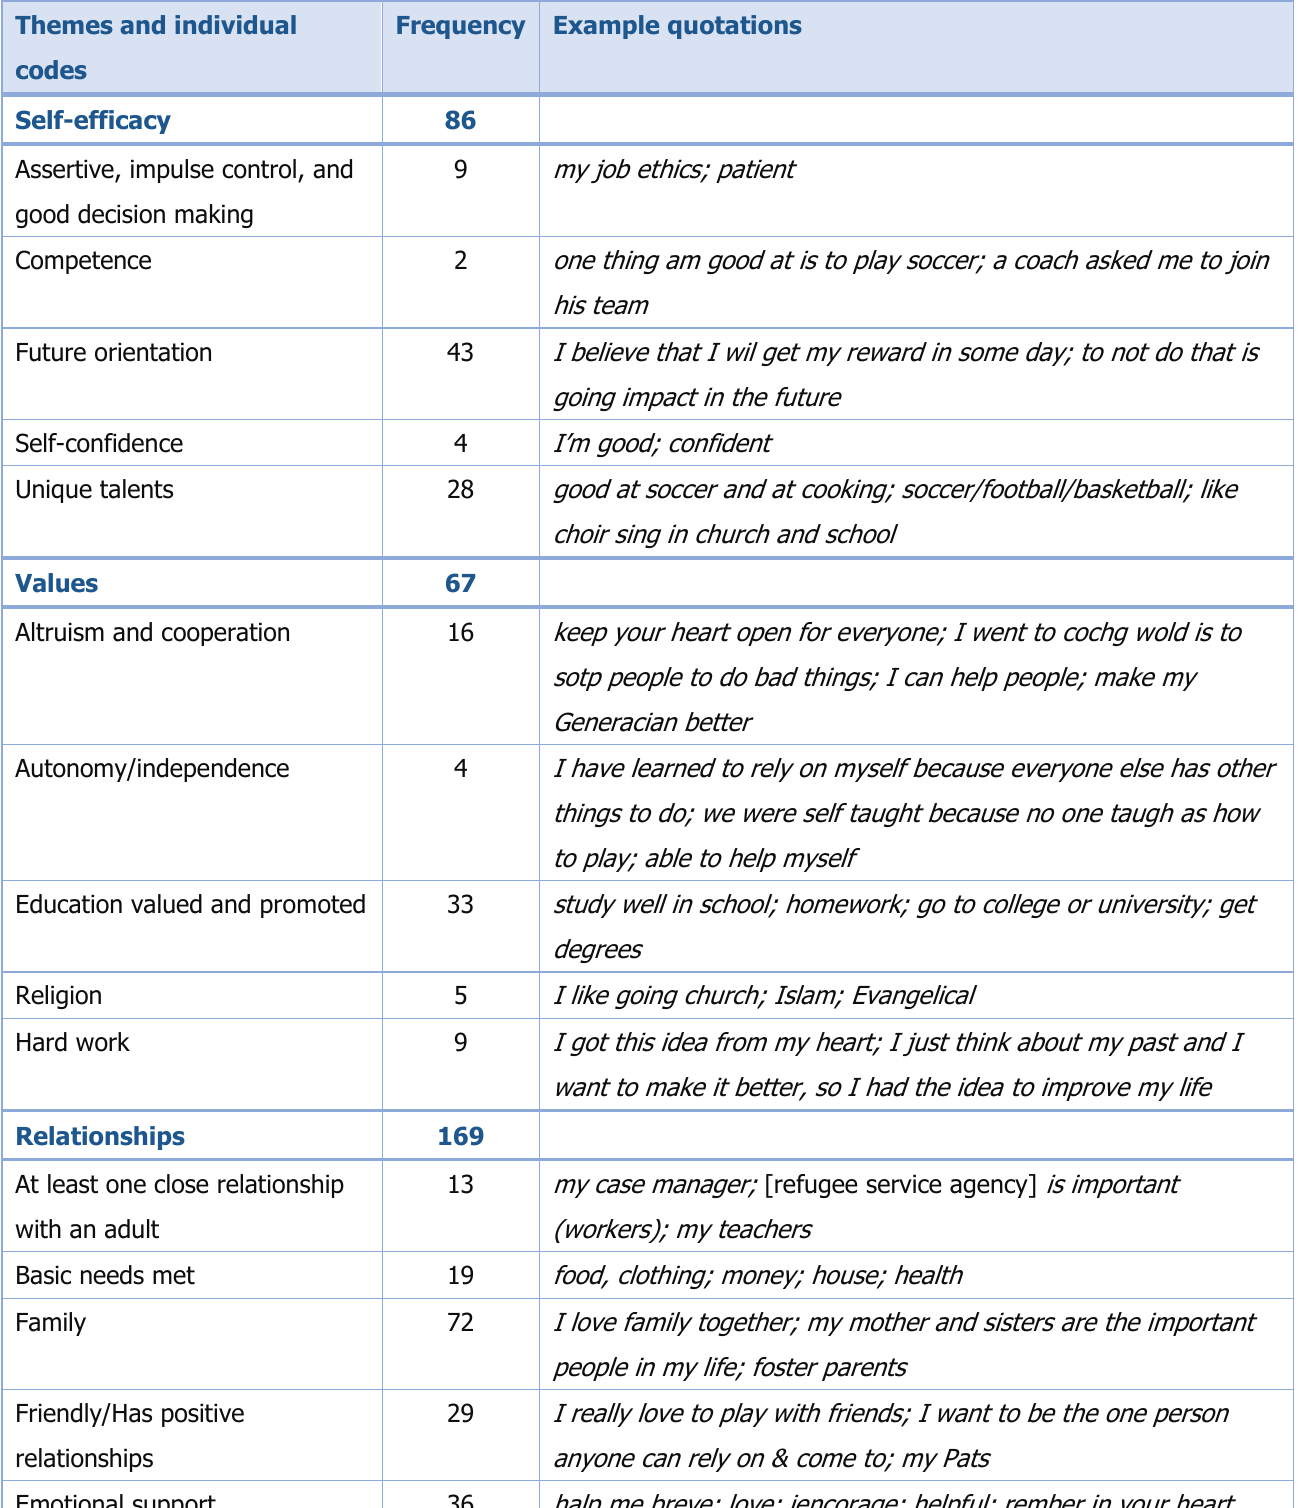
Table 2. Themes, Coding Frequency, and Example Quotations Themes and